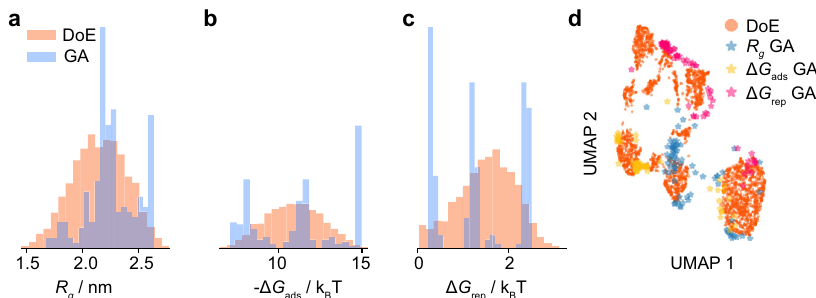
Fig. 8 Distribution of properties for the polymers found by inverting the machine learning models using a genetic algorithm (GA). To generate new feature vectors, we ran the genetic algorithm with different weights for the novelty part of the loss function — ranging from no penalty for similar polymers to high (50 times the objective) penalty for polymers similar to the ones already sampled with our design of experiments (DoE). In addition, we run the genetic algorithm for different elitist ratios. For each feature vector, three possible polymer bead sequences were generated, as a feature vector does not map to one unique arrangement of monomers. a Distribution of radius of gyration ( R g ). b Distribution of adsorption energies Δ G ads . c Distribution of